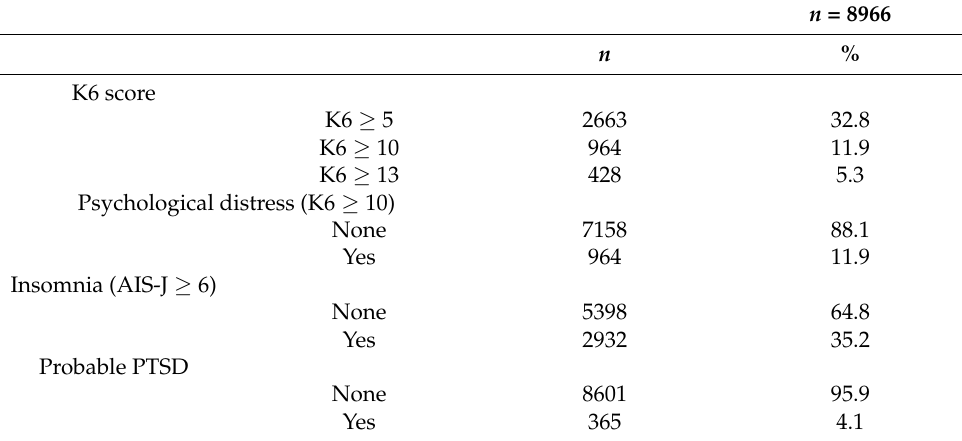
Table 2. Prevalence rates of mental health problems among study